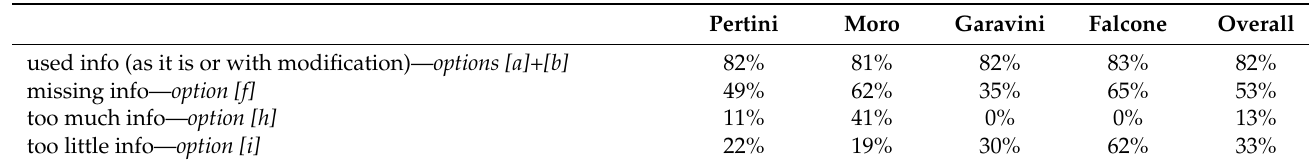
Table 4. Results (percentage of answers). Options refer to Appendix A. Pertini Moro Garavini